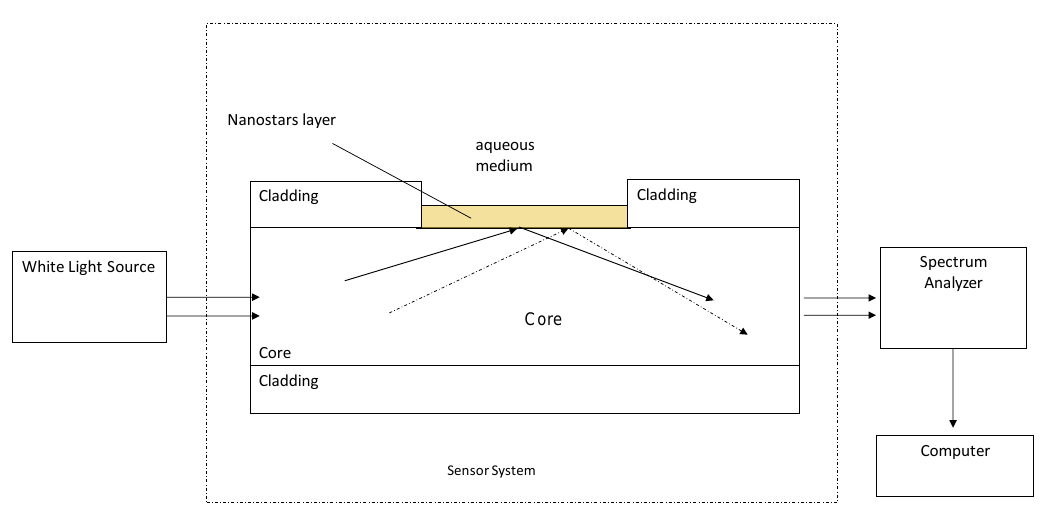
Figure 4. Setup to measure the transmitted light